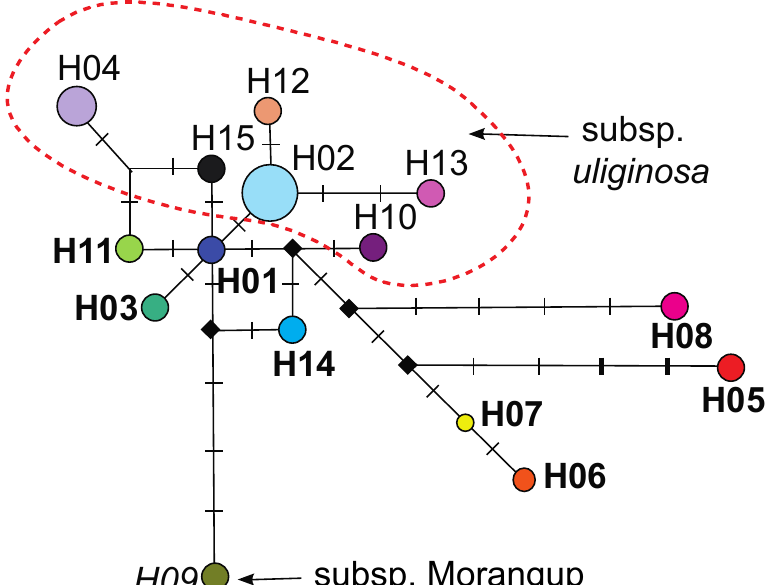
Figure 2. Median-joining maximum parsimony (MJMP) network of chloroplast haplotypes observed in Banksia nivea from south-western Australia. Circle sizes are proportional to haplotype frequency among samples. Black dashes represent a single nucleotide substitution (not bold) or indel (bold). Black boxes represent inferred unsampled haplotypes. Haplotype numbers and colors correspond to those in Figure 1.